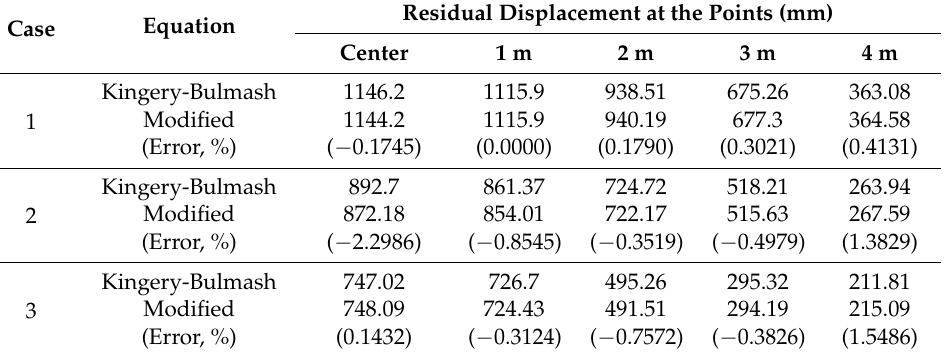
Table 9. Results of Free-Air Burst Simulations.